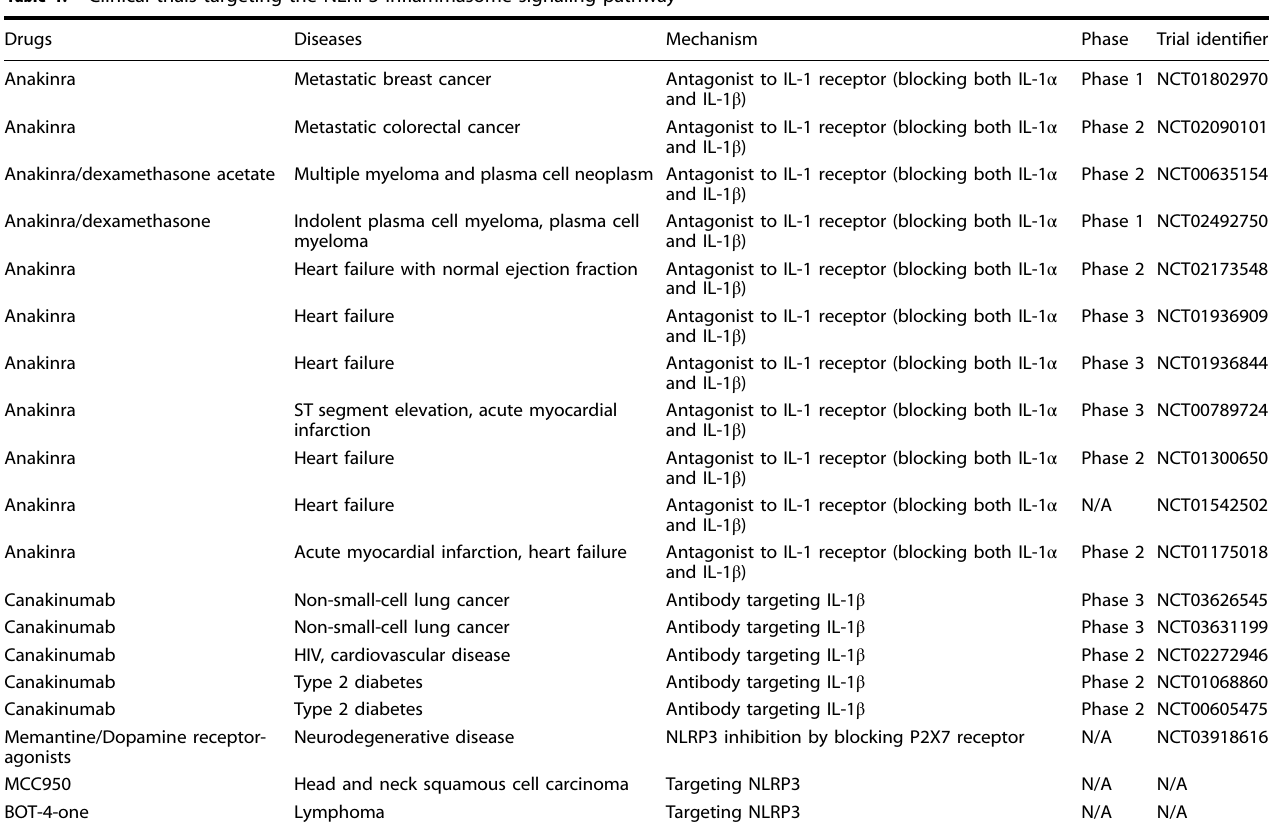
Table 1. Clinical trials targeting the NLRP3 in fl ammasome signaling pathway